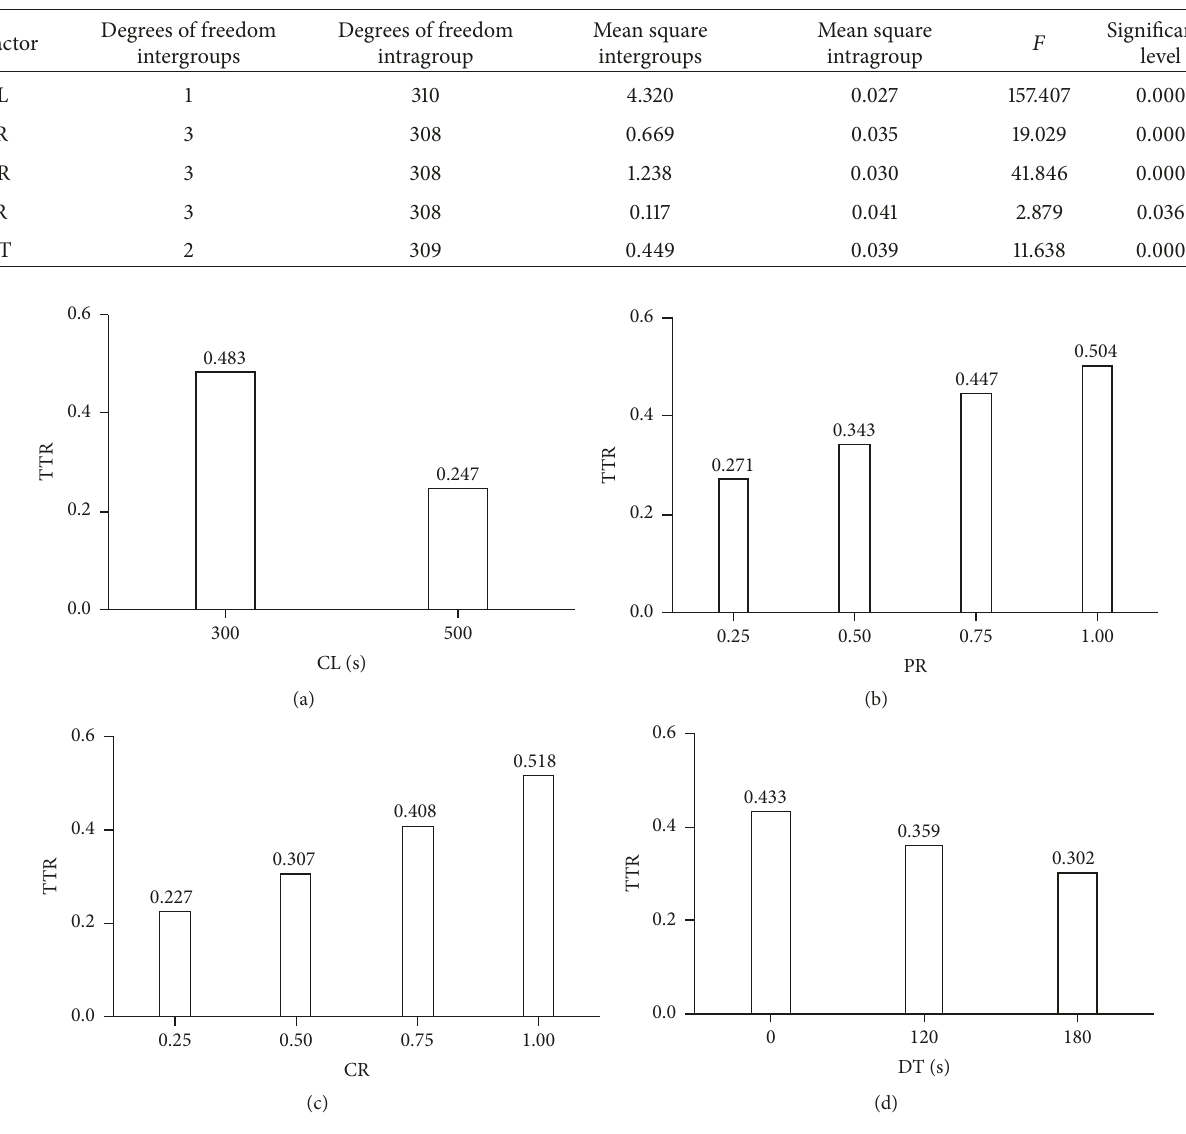
Table 3: Results of correlation analysis.